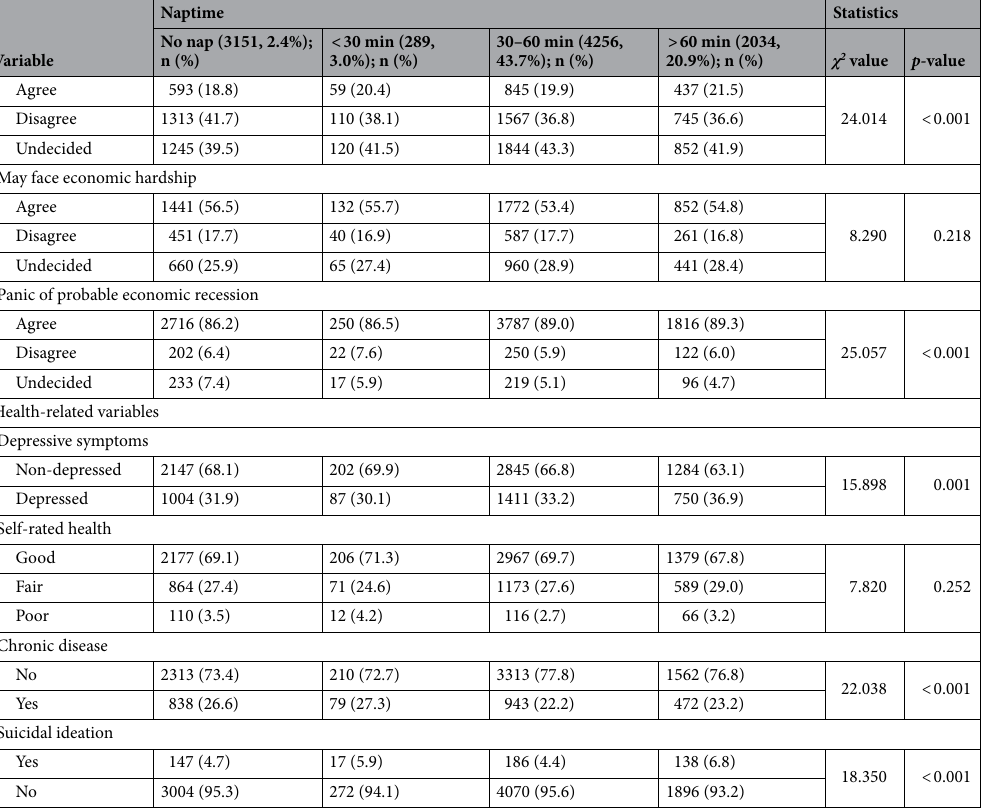
Table 2. Associations between the study variables and daily